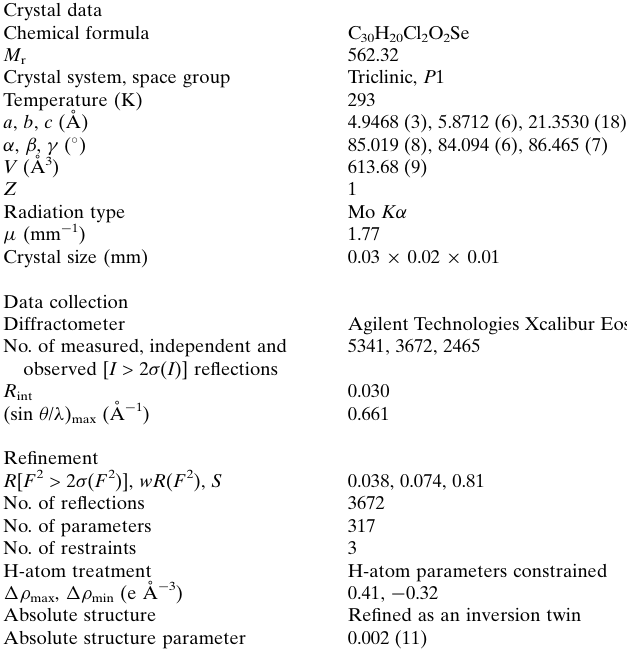
Crystal data Chemical